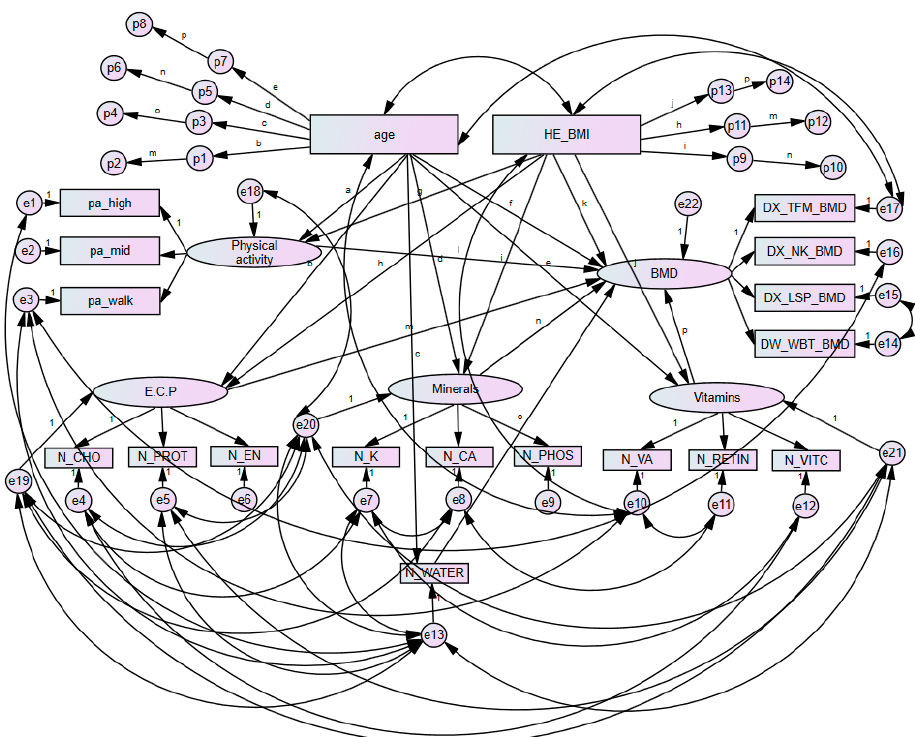
Figure 3. Results of mediated pathways with age, BMI, physical activity, and nutrient intakes in premenopausal women with bone mineral density. Errors are presented with e1, e2, e3, e4, e5, e6, e7, e8, e9, e10, e11, e12, e13, e14, e15, e16, e17, e18, e19, e20, e21 and e22. Phantom variables are presented with p1, p2, p3, p4, p5, p6, p7, p8, p9, p10, p11, p12, p13 and p14. BMD, bone mineral density; N_CA, calcium; N_CHO, carbohydrate; N_EN, energy; E.C.P., energy, carbohydrates, and protein; DX_NK_BMD, femoral neck bone mineral density; pa_high, high intense physical activity; DX_LSP_BMD, lumbar spine bone mineral density; pa_mid, moderate intense physical activity; N_PHOS, phosphorus; N_K, potassium;